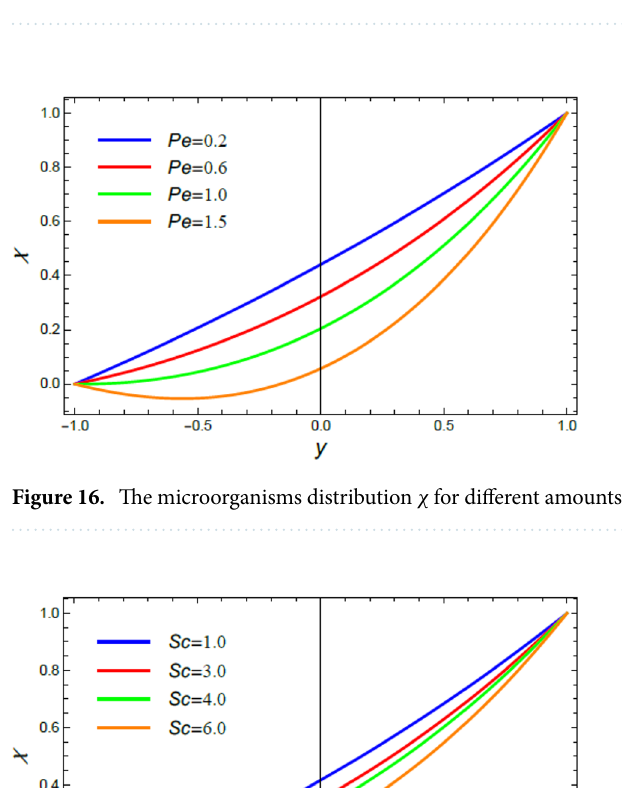
Figure 15. The nano-particles profile φ in the case of heat source for different amounts of the Prandtl numeral Pr .